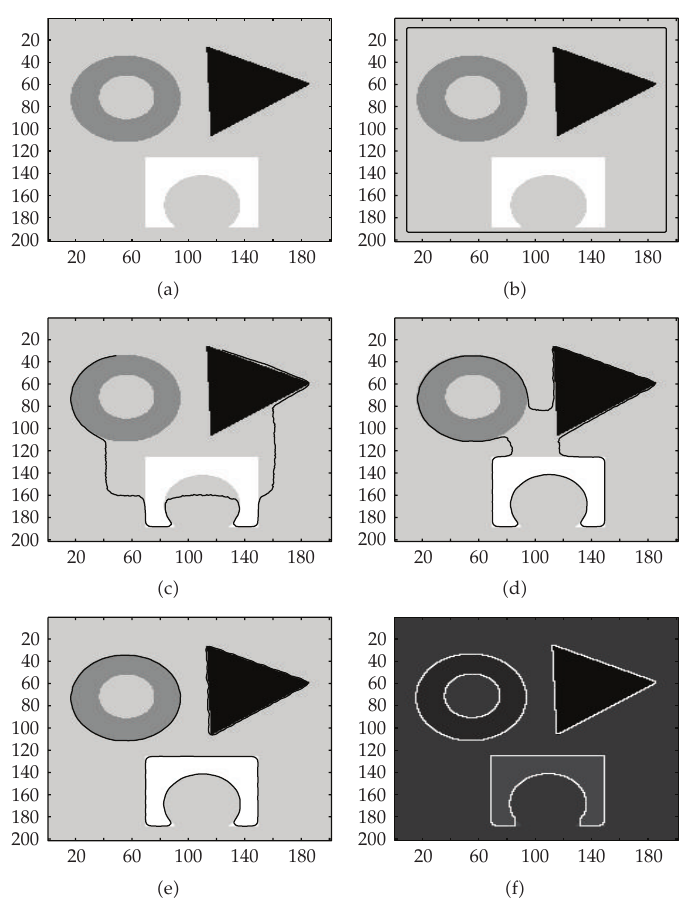
Figure 9: Segmentation results of a synthetic image using an active contour model: di ff erent iterations are displayed from (cid:7) b (cid:8) to (cid:7) e (cid:8) , (cid:7) f (cid:8) is the segmented image using our new